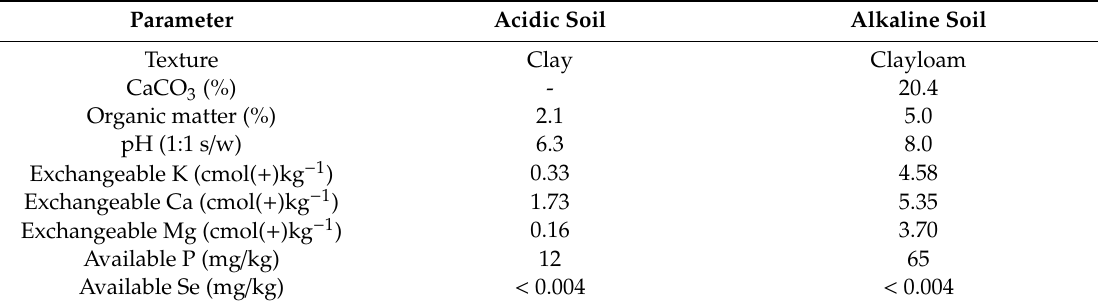
Table 1. Selected physicochemical properties of the soils at the start of the experiment.